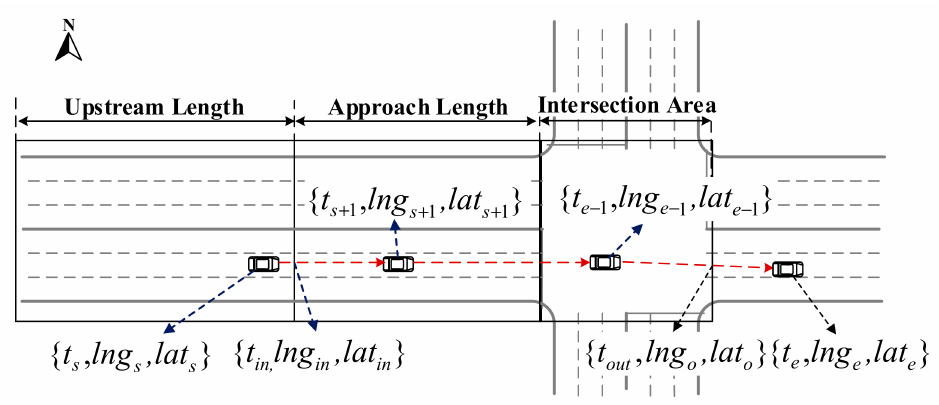
Figure 9. The passing time of the